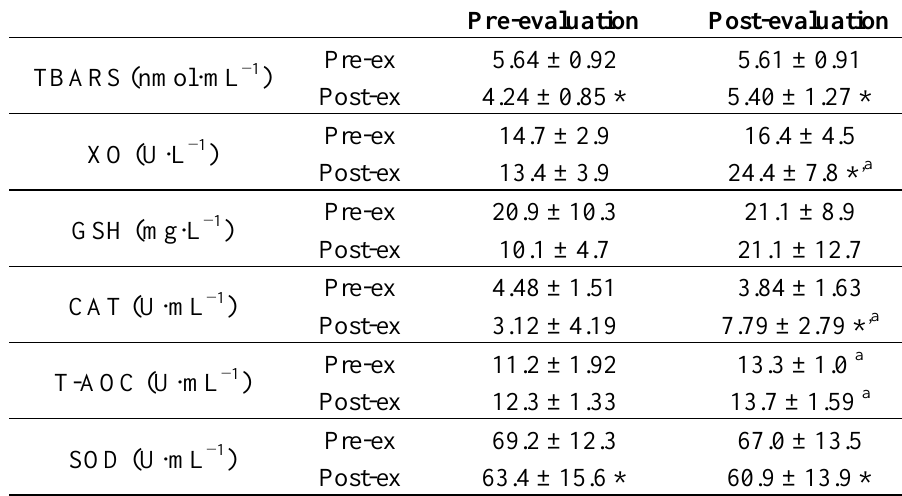
Table 1. Changes in the levels of serum thiobarbituric acid-reactive substances (TBARS), xanthine oxidase (XO), reduced glutathione (GSH), catalase (CAT), total antioxidant capacity (T-AOC), and superoxide dismutase (SOD) induced by the maximum 21-km run during the pre- and post-evaluation trials ( n =